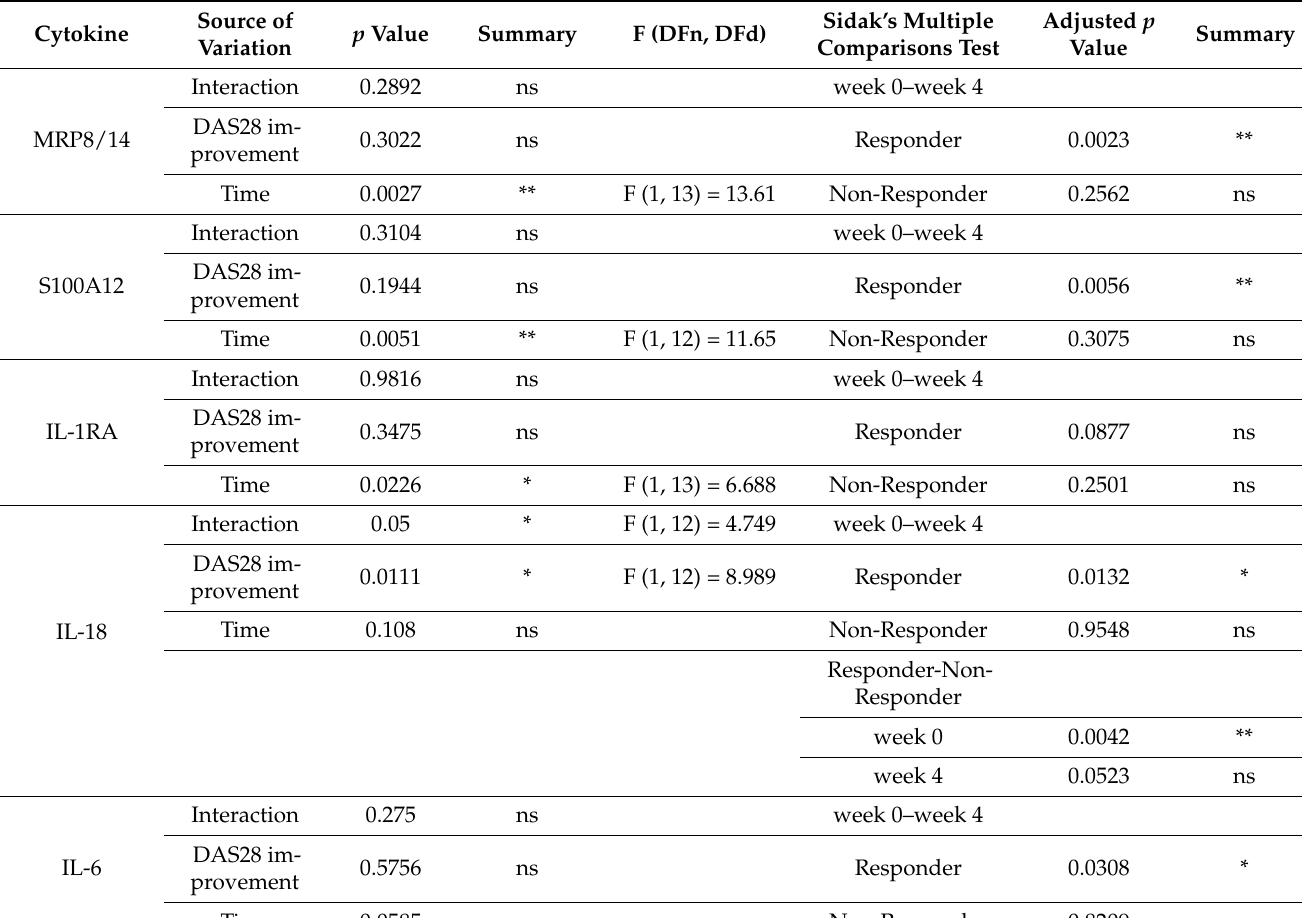
Table 4. Detailed results of two-way repeated-measures ANOVA with Sidak’s multiple comparisons test for responders and non-responders. * p < 0.05, ** p <